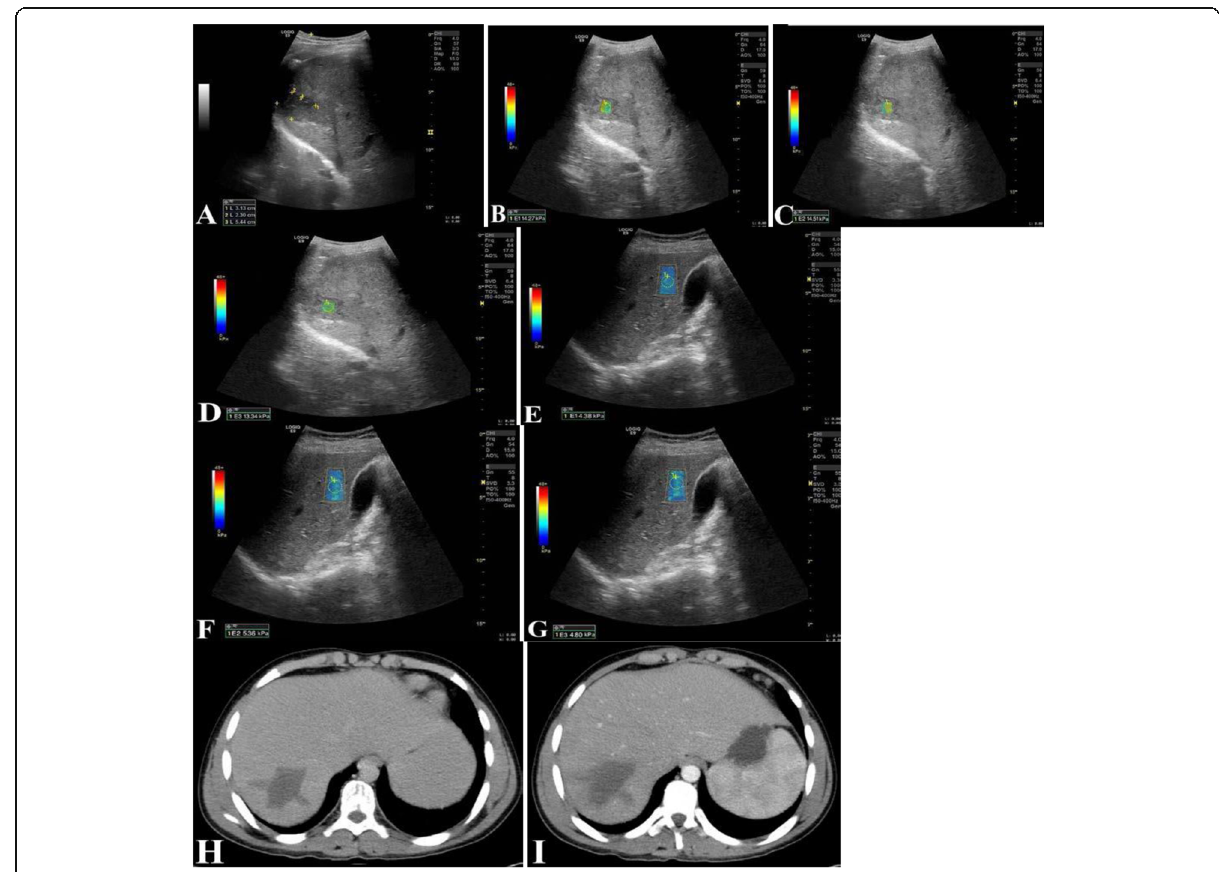
Fig. 6 Thirty-seven years old male patient with non-Hodgkin lymphoma seeking for abdominal ultrasound to exclude abdominal lymphomatous infiltration. Imaging findings: grey scale B-mode ultrasonography ( a ): normal sized liver with an ill-defined hypoechoic focal lesion seen in segment VII measuring 3.1 × 2.3 cm with 5.4 cm depth from the skin. ϖ Color-coded shear wave sono-elastography: the lesion showed yellow green color ( b , c , d ), while the liver parenchyma showed dark blue color ( e , f , g ). ϖ Shear wave sono-elastography stiffness values of the focal lesion: E1 = 14.27 kPa ( b ), E2 = 14.51 kPa ( c ), and E3 = 13.34 kPa ( d ). Calculated average stiffness value of the lesion = 14.04 kPa. ϖ Shear wave sono-elastography stiffness values of the parenchyma ( e , f, g ): E1 = 4.38 kPa ( e ), E2 = 5.36 kPa ( f ), and E3 = 4.80 kPa ( g ). Calculated average stiffness value of the parenchyma = 4.84 kPa. (cid:129) Lesion/parenchyma stiffness ratio = 2.90. ϖ Axial contrast enhanced CT study (non-contrast ( h ), post contrast ( i )): normal size liver with a well-defined hypodense focal lesion seen in segment VII showed faint peripheral enhancement.